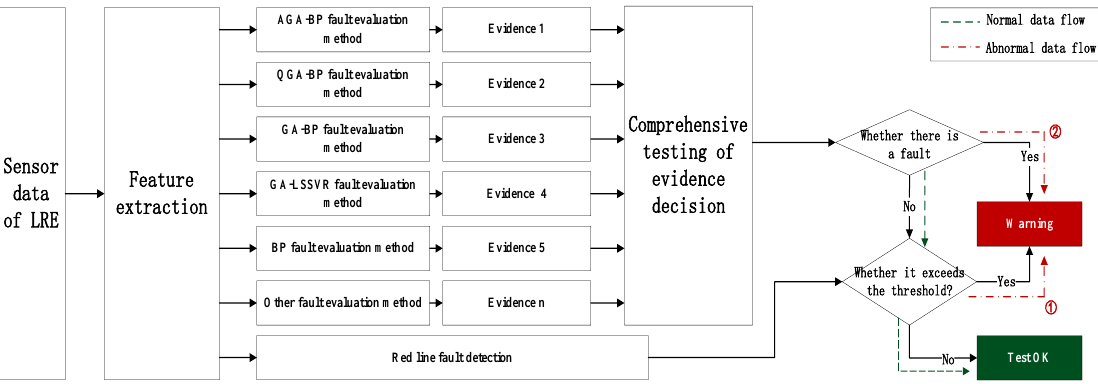
Figure 13. Flow chart of comprehensive fault detection of a liquid rocket engine.